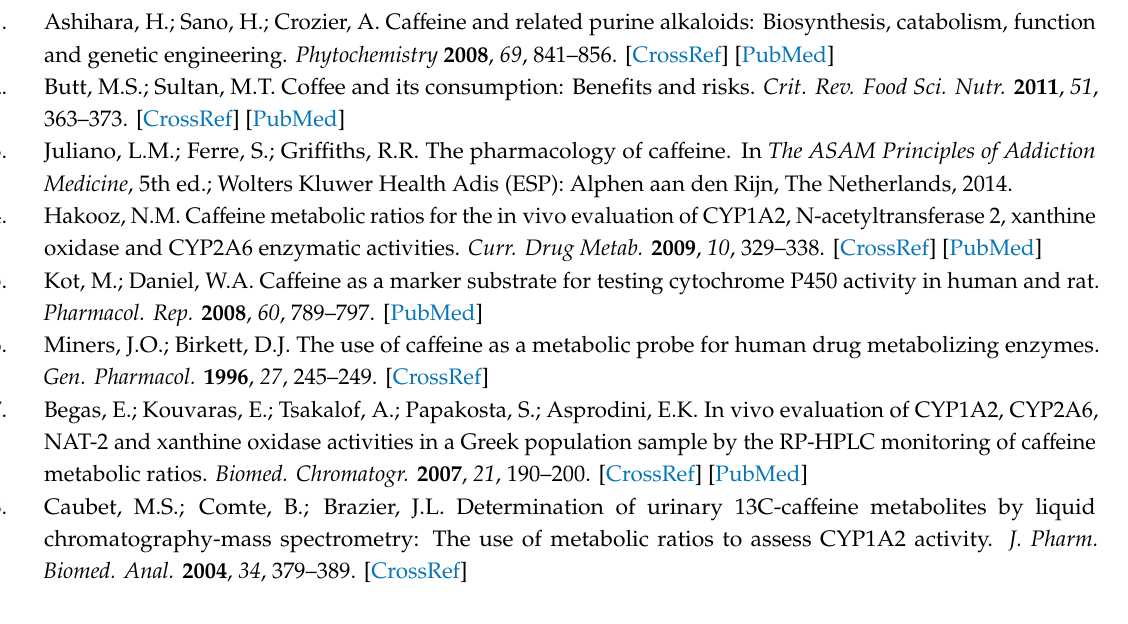
Figure S1: Representative LC-MS / MS extracted ion chromatograms for ca ff eine and its metabolites in human urine at 2 h after administration of ca ff eine-containing drink, Table S1: Concentrations of quality control standards for ca ff eine and its metabolites, Table S2: Calibration range, retention time and multiple reactions monitoring data for ca ff eine and its metabolites, Table S3: Matrix e ff ect data for ca ff eine and its metabolites, Table S4: Recovery data for ca ff eine and its metabolites, Table S5: Stability of ca ff eine and its metabolites in various